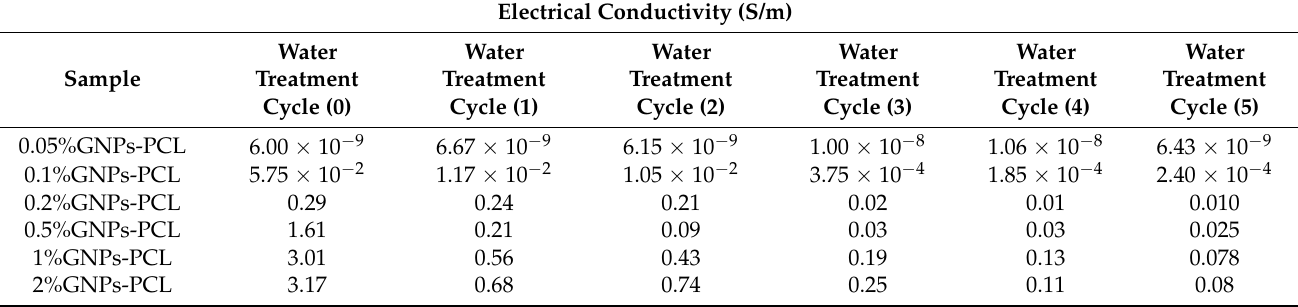
Table 2. Electrical conductivity results as a function of the concentration of GNPs and the amount of water treatment cycles performed from 1 to